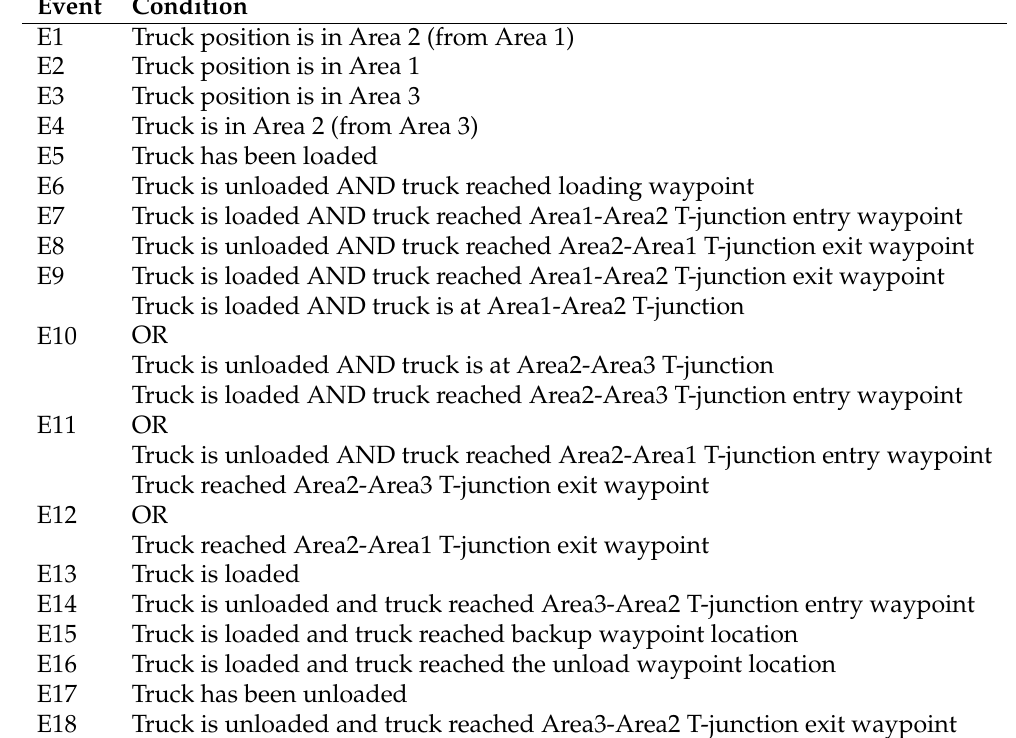
Figure 2. Finite state machine logic for the operational decomposition of a load-haul-dump operation. E1 to E18 define the state transition events. Table 1. State transition events for the finite state machine logic developed for the operational